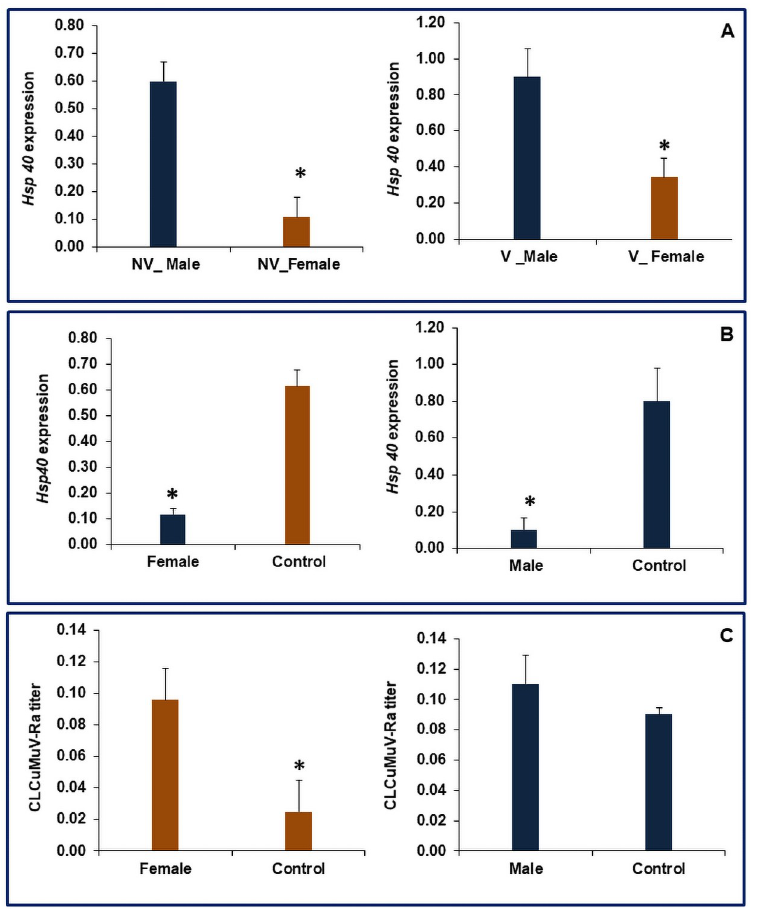
Fig 7. Relative expression of Hsp40 in B . tabaci , A. Non-viruliferous and viruliferous whiteflies, B. dsRNA fed female and male whiteflies; C. Relative titer of Cotton leaf curl Multan virus -Rajasthanin Hsp40 knockdown viruliferous female and male whiteflies. The expression level was normalized with β -tubulin as housekeeping gene. Error bars represent the standard deviation (n = 3) and � represents significant differences in expression (P � 0.05, Student’s t-